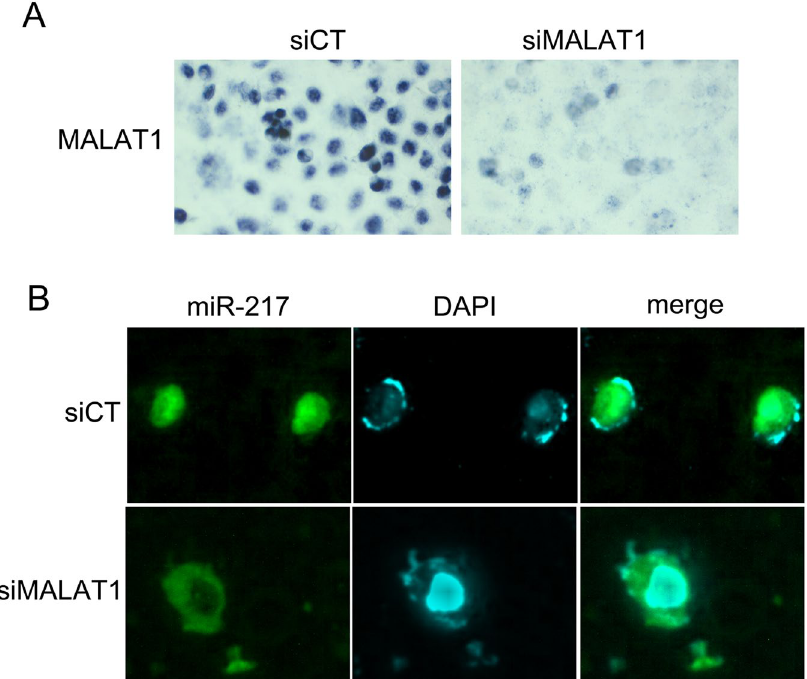
Figure 7. MALAT1 kncokdown (A) promoted the migration of miR-217 from the nucleus to the cytoplasm